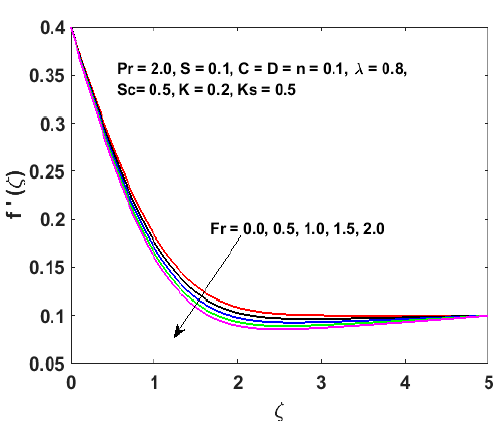
Figure 3. Effect of inertia coefficient ( F r ) on f (cid:48) ( ζ ) .